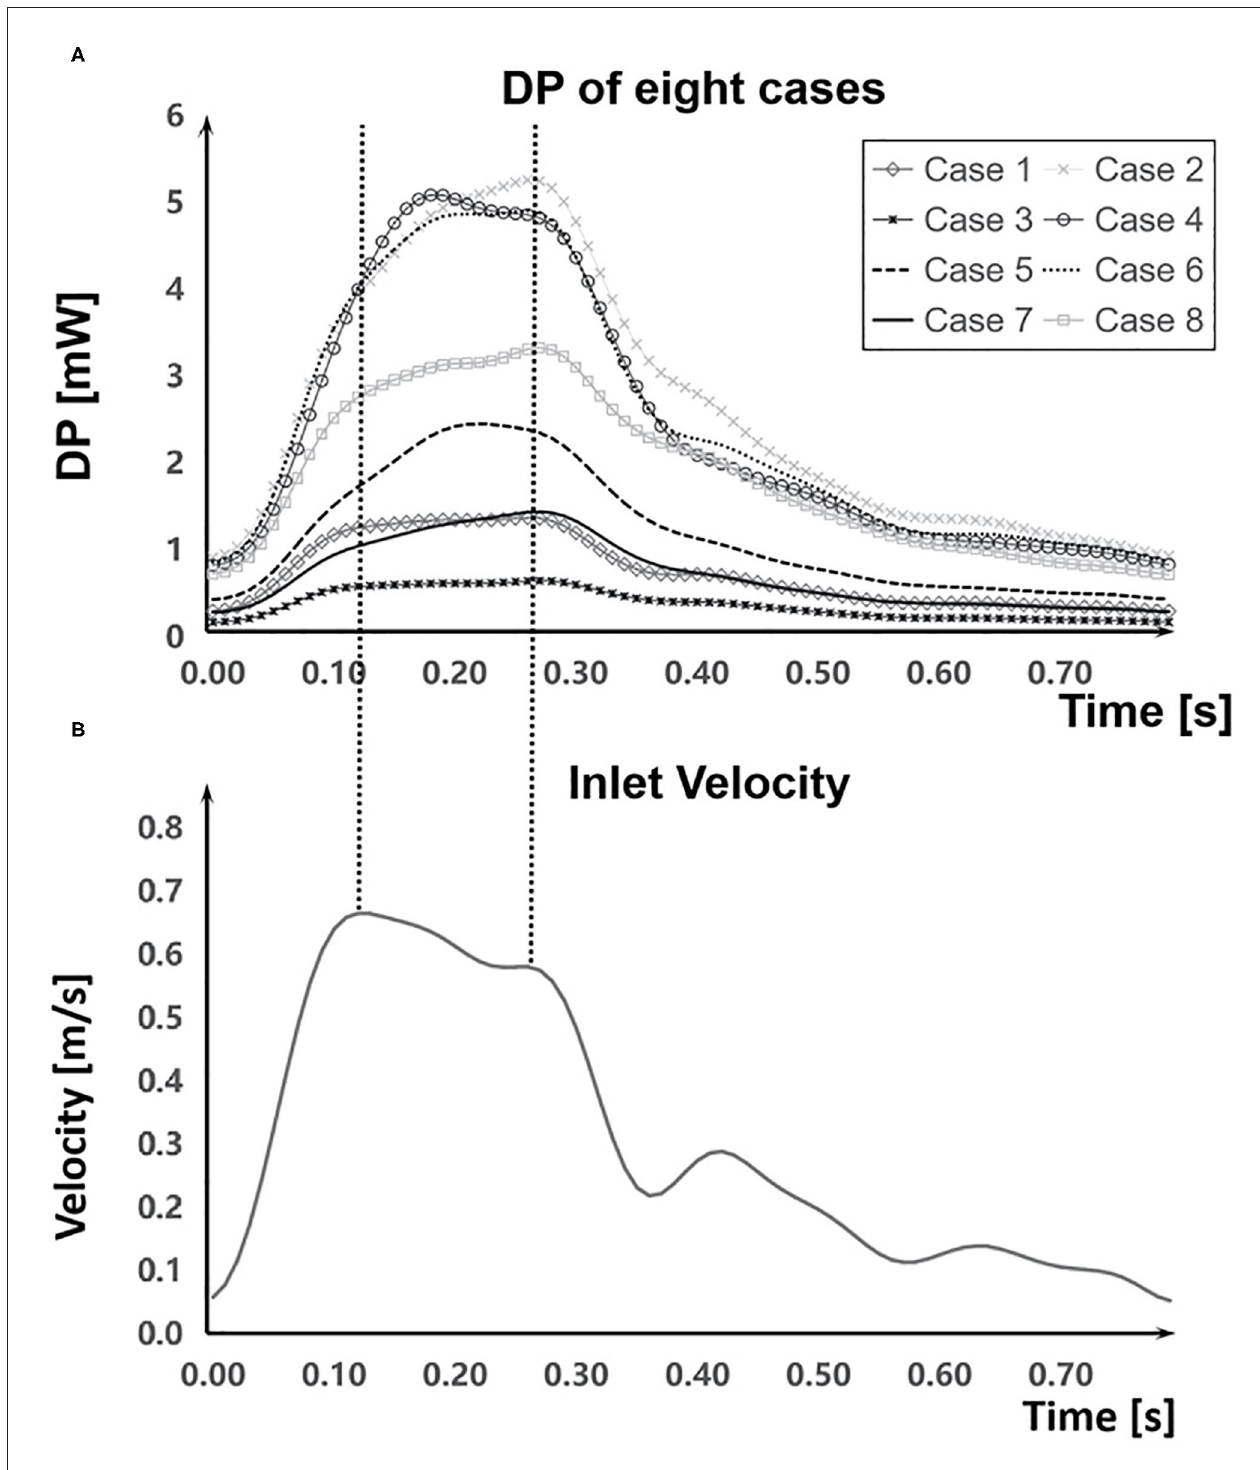
FIGURE 5 | Comparation of DP and the inlet velocity during a cardiac cycle. (A) DP in aneurysm part during a cardiac cycle of each case. (B) The inlet velocity of inlet part.